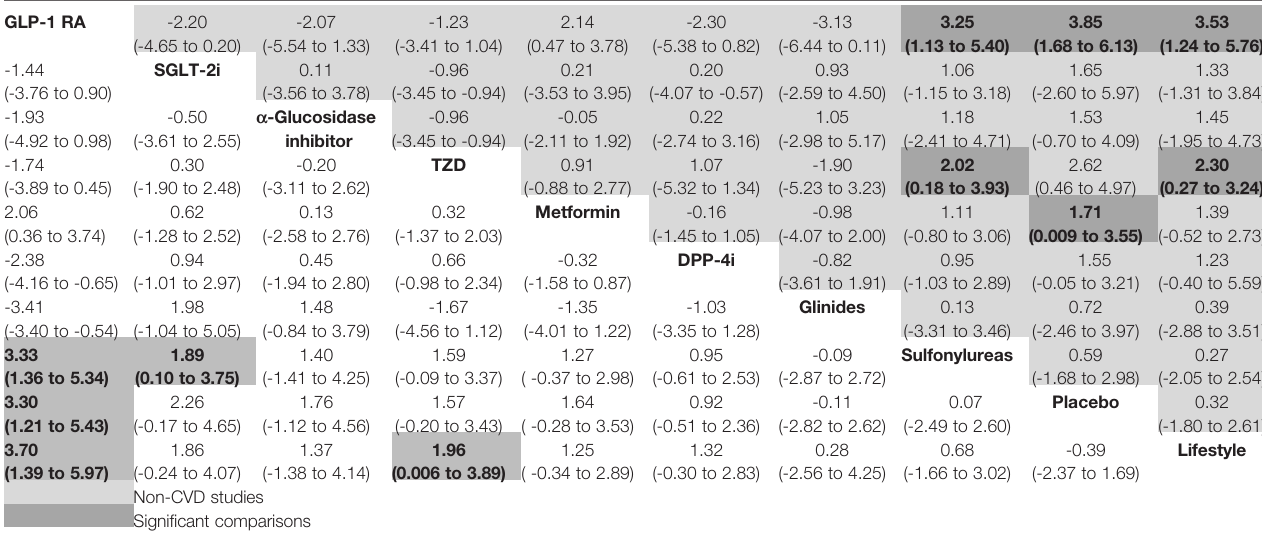
TABLE 2 | Network meta-analysis results for D FMD in all studies (30 trials, left lower half) and non-CVD studies (25 trials, right upper half). GLP-1